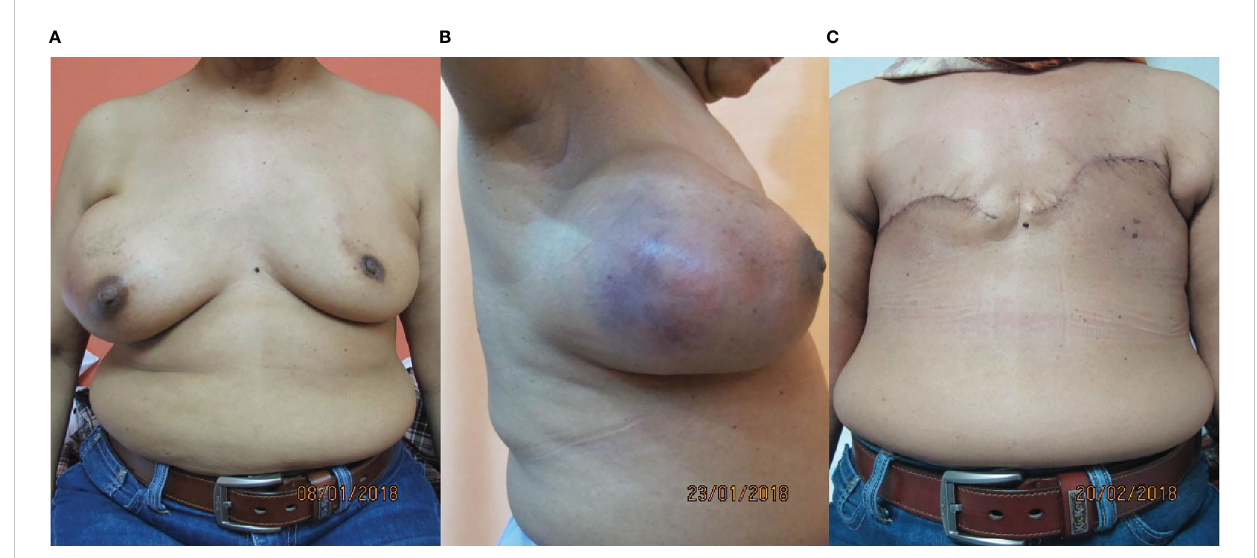
FIGURE 2 Photos of the patient. (A, B) Preoperatively, front and right lateral views. (C) Postoperatively, front.